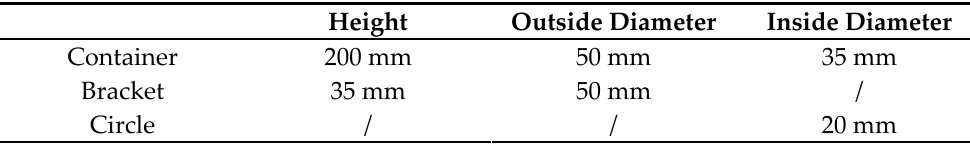
Table 3. The Parameters of the 3D-designed